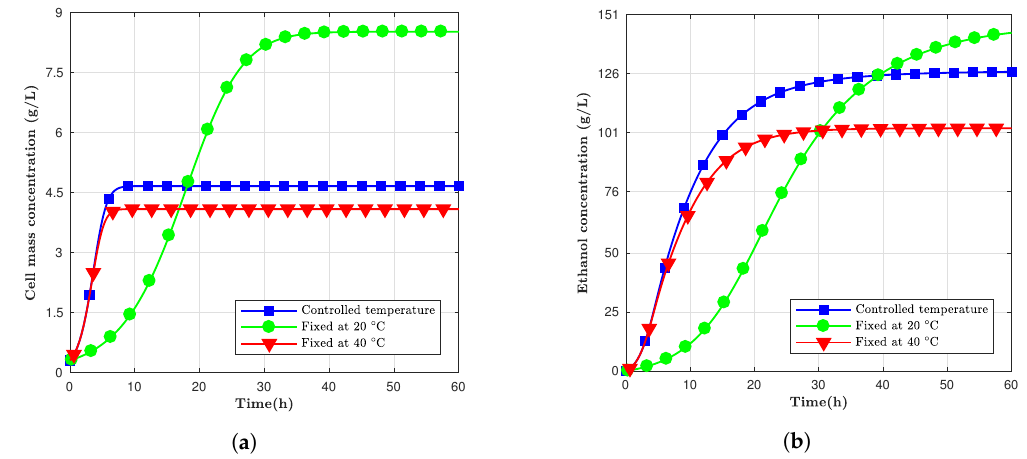
Figure 3. The concentration of ( a ) cell mass and ( b ) ethanol for simulations at fixed and controlled temperatures in a 60 h